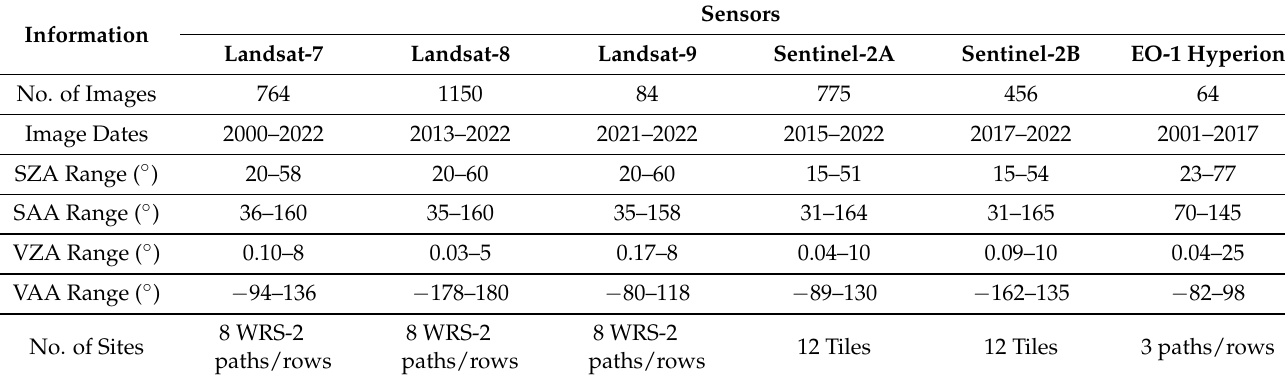
Table 1. Different sensor information used in the DAHAC model’s